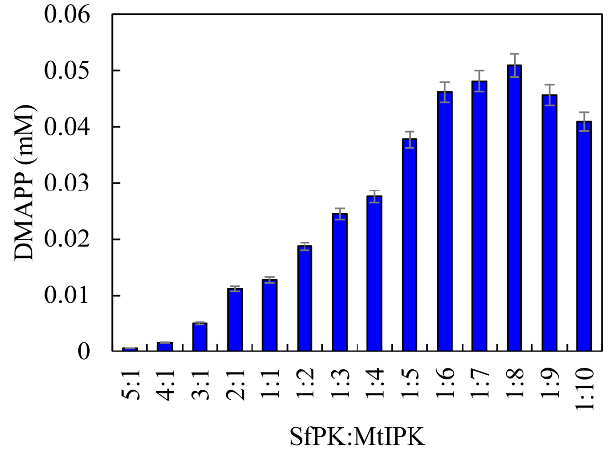
Figure 10. Effect of enzyme concentration on the production of DMAPP via the one-pot enzymatic cascade. Because it is difficult to directly detect DMAPP production in the one-pot enzymatic cascade, DMAPP production was determined by detecting the concentration of 7-dimethylallyl tryptophan, which was transformed from tryptophan by prenyltransferase (7-DMATS). HPLC and LC–MS of 7-dimethylallyl tryptophan and tryptophan have been provided in Figure S3. The m/z value of the molecular ion [M-H]- of the one-pot enzymatic product was 271.1460, which was equal to the m/z value of 7-dimethylallyl tryptophan. This results showed that DMAPP was produced from DMA by the one-pot enzymatic cascade.